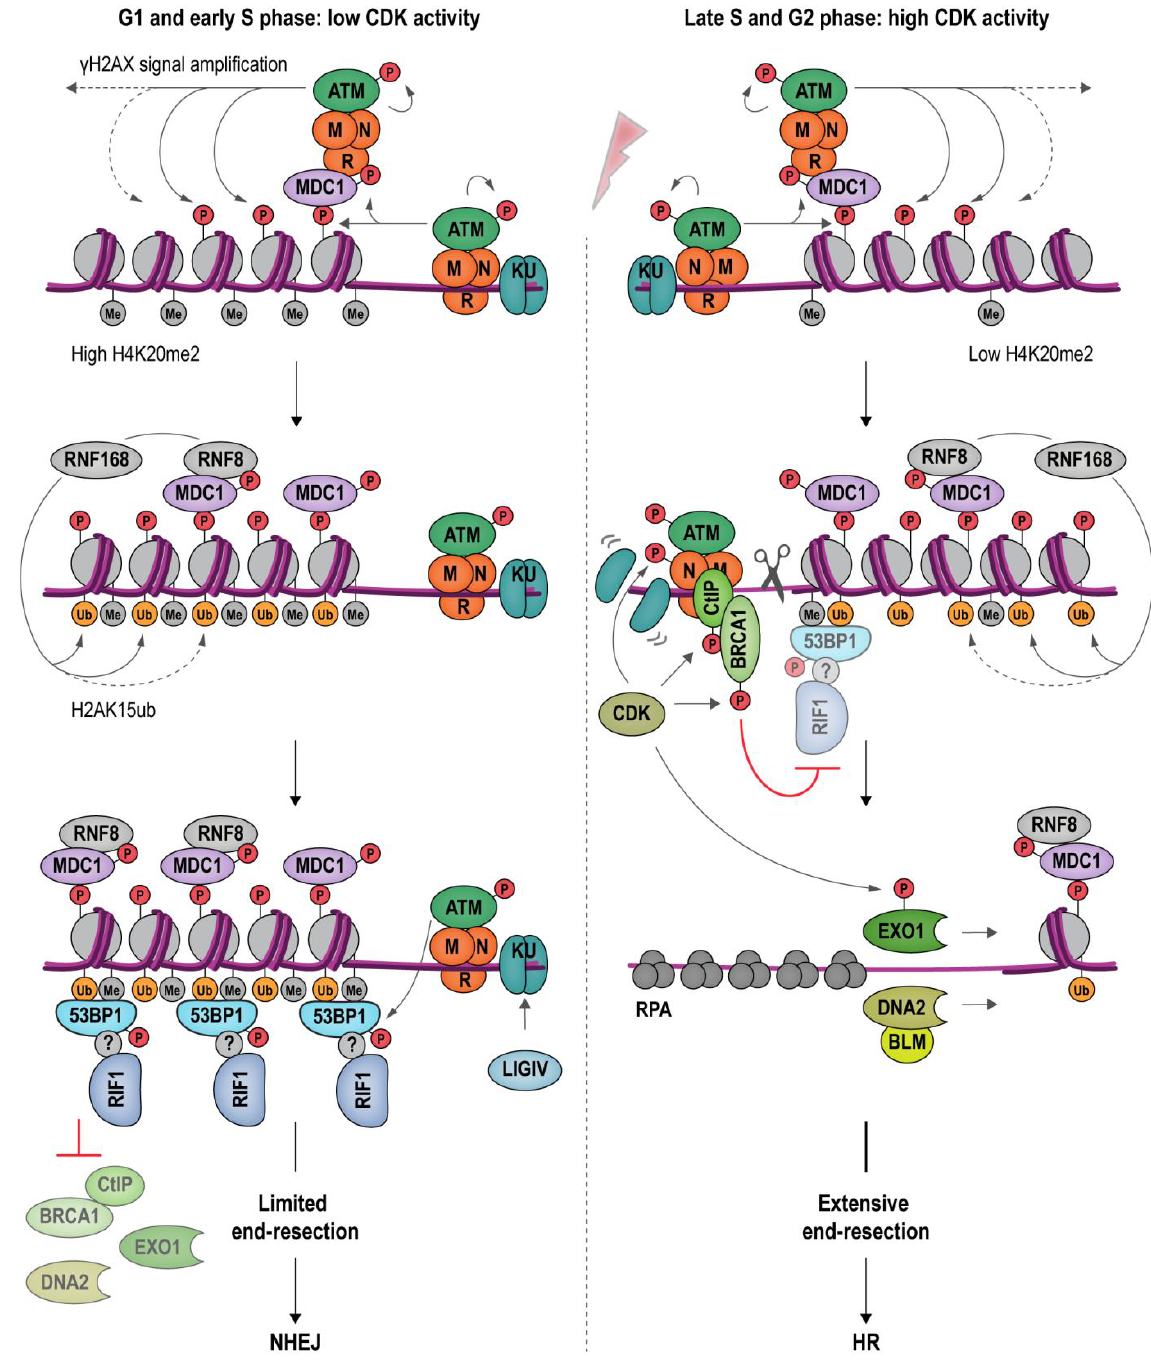
FIGURE 6: An antagonism between 53BP1-RIF1 and BRCA1-CtIP regulates DSB repair pathway choice in mammalian cells. DSB formation triggers a range of protein modifications that orchestrate the cellular response and DNA repair. MRN binds DSBs and recruits apical DDR kinase ATM, which phosphorylates H2AX (γH2AX). γH2AX attracts MDC1 (Mediator of DNA damage checkpoint protein 1), which becomes phosphorylated by ATM and binds additional MRN and ATM, providing a positive feedback loop for signal amplification. MDC1 also recruits RNF8, which cooperates with RNF168 to catalyze protein ubiquitylation at DSBs. H2AK15ub, together with H4K20me2, mediates binding of 53BP1 at DSBs. In its ATM-phosphorylated form, 53BP1 interacts with RIF1, although it remains to be determined whether this interaction is direct. The 53BP1-RIF1 complex blocks resection and inhibits BRCA1-CtIP, EXO1 and DNA2 through an as yet unidentified molecular mecha- nism. Attenuation of resection results in NHEJ repair in G1 and in early S phase ( left ). In late S and G2 phase, CDK activity rises and the H4K20me2 mark is diluted as a consequence of new histone deposition during DNA replication. CDK stimulates the endonucleolytic activity of the MRN complex, and the recruitment of BRCA1-CtIP to damaged chromatin, while 53BP1-RIF1 binding is diminished. CDK-phosphorylated EXO1 and DNA2-BLM promote long-range resection, generating 3ʹ-ssDNA overhangs, the substrate for the HR-dependent DSB repair machin- ery ( right